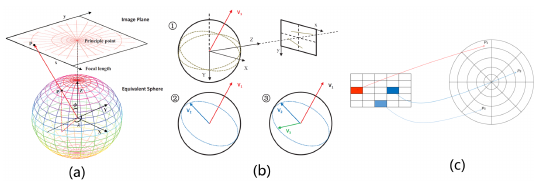
Figure 6. Schematic diagram of the process of generating